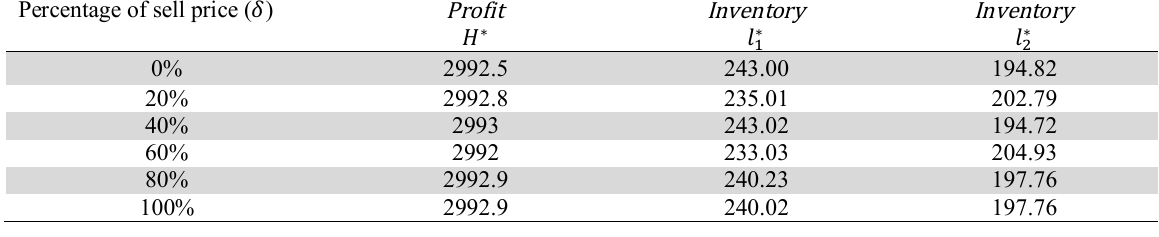
Sensitivity analysis of the ratio ( (cid:2012) ) Percentage of sell price ( (cid:2012) )